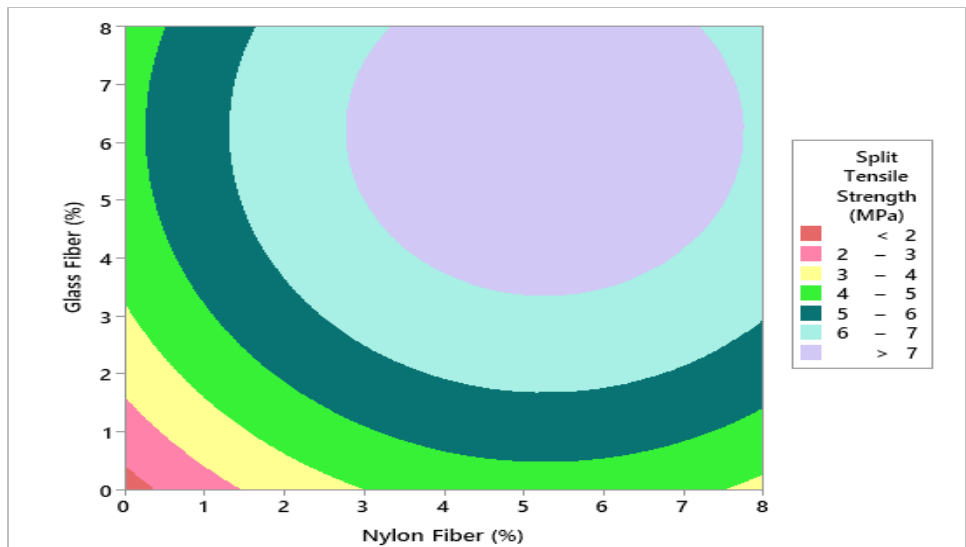
Figure 11. Contour plot for split tensile strength.